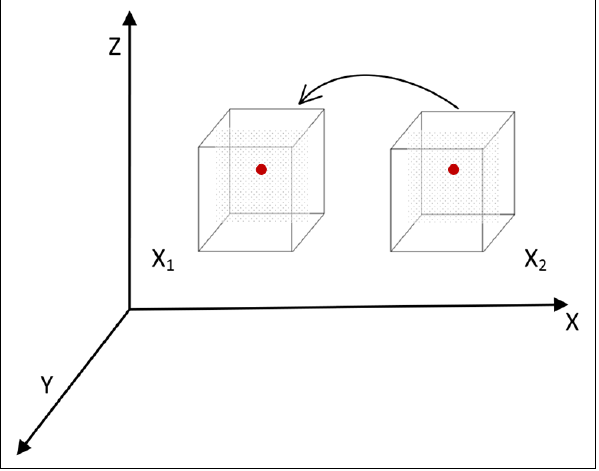
Figure 2. Block-to-point correspondence in fine registration. The red points are